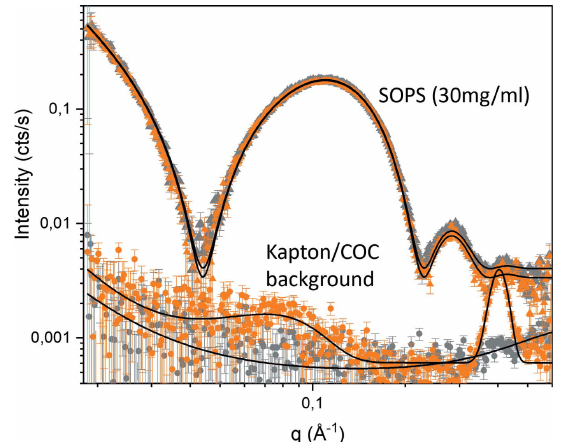
Figure 2 In-house measurements with Kapton and COC windows. Triangles: SAXS signal with error bars (orange/grey: Kapton/COC windows) of SOPS unilamellar vesicles with a diameter of 100 nm (30 mg ml (cid:4) 1 ). Solid lines correspond to the best fit for flat symmetrical bilayers (see supporting information for model and detailed fit parameters). Circles: SAXS signal with error bars of the empty dialysis chamber with 50 m m- thick Kapton (orange) and 100 m m-thick COC windows (grey). Solid lines correspond to the best fit for a power law with one and two Gaussians. The samples were measured with an exposure time of 1 min per frame and measured for 6 h in total.